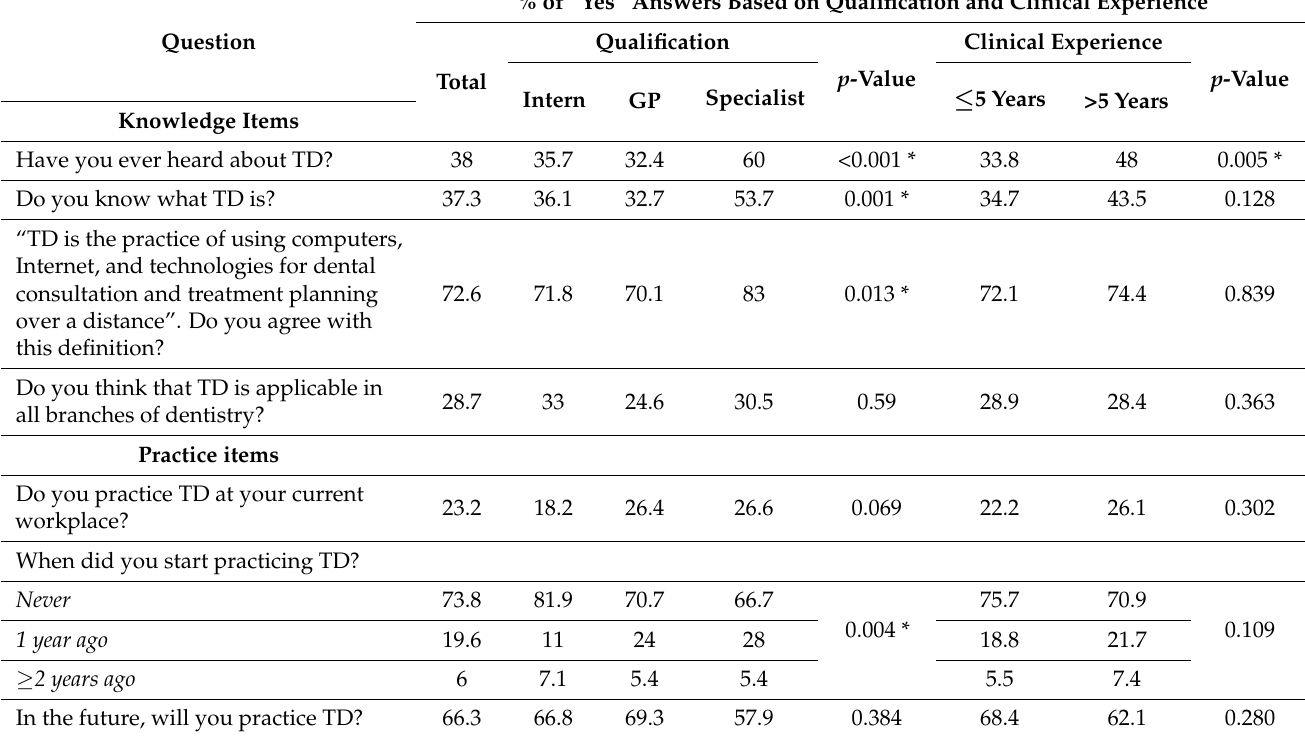
Table 2. Responses of participants to knowledge- and practice-related questions by qualification and clinical experience ( n =